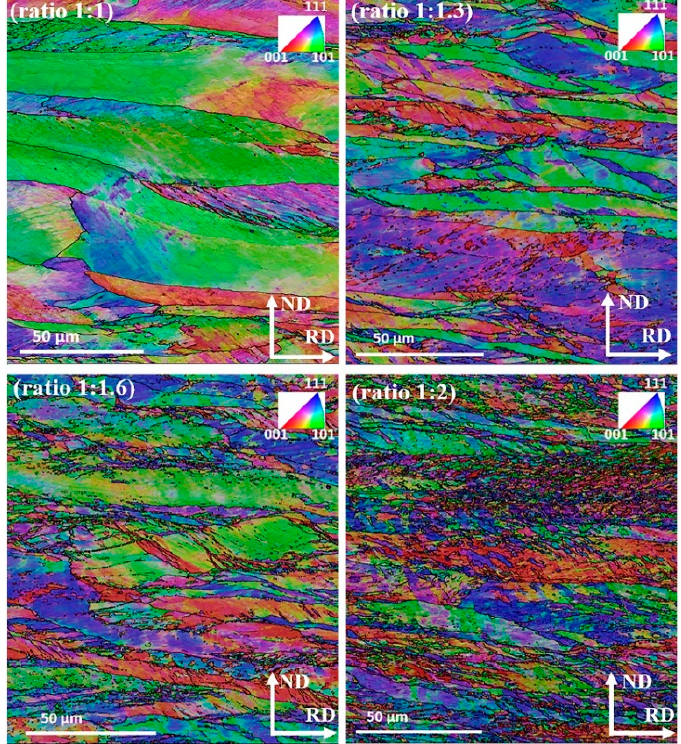
Figure 8. IPF maps taken on the TD surface (by projecting the RD axis), in the mid thickness area of a sheet at TRPP of 75% with an increase in the roll diameter ratio from 1:1 to